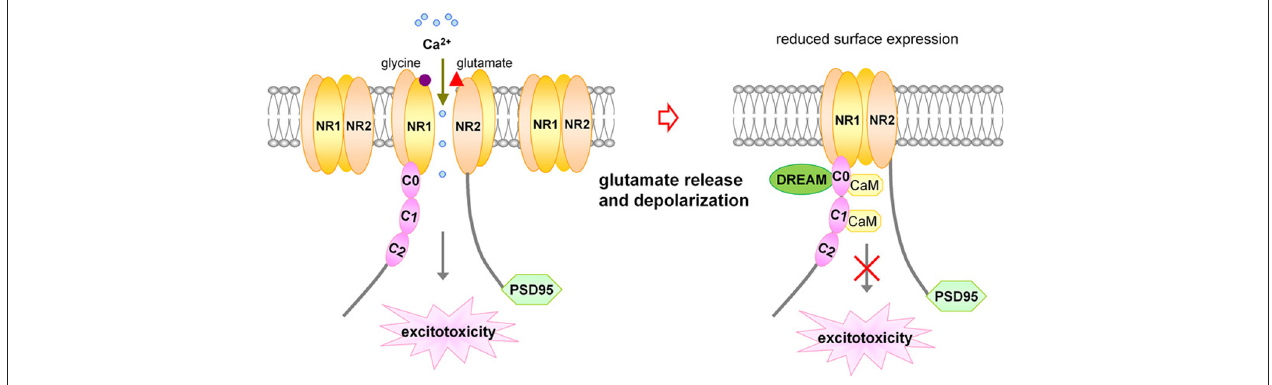
resulting in reduced surface expression of NMDARs, and subsequent inhibition of NMDARs-mediated Ca 2 + influx and excitotoxicity. DREAM functions as a Ca 2 + -sensitive modulator for the negative feedback control of NMDAR